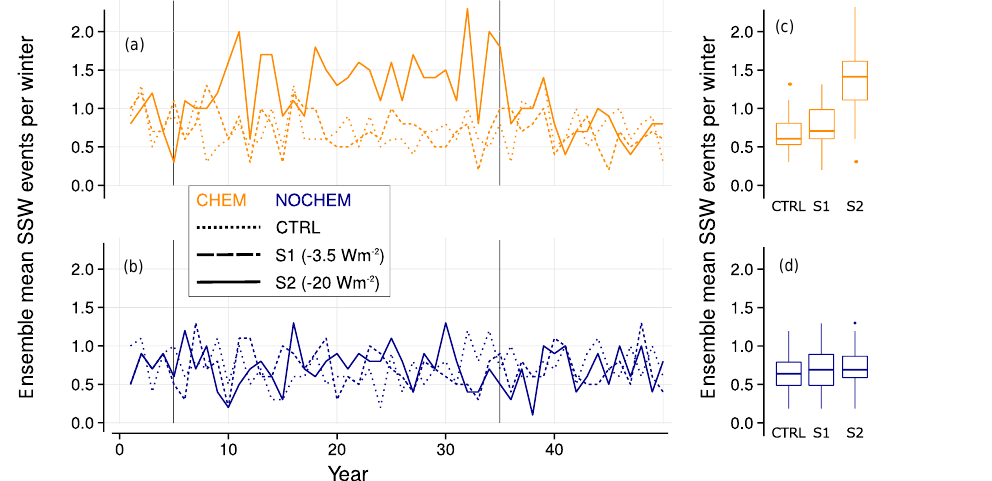
Figure 6. (a, b) Ensemble mean number of sudden stratospheric warming (SSW) events per winter season (November–March) as in defined by Charlton and Polvani (2007). (c, d) Box plot statistics for the number of SSW events per winter season averaged over the SRR period. The beginning and the end of the SRR period are indicated by vertical lines in panels (a) and (b)